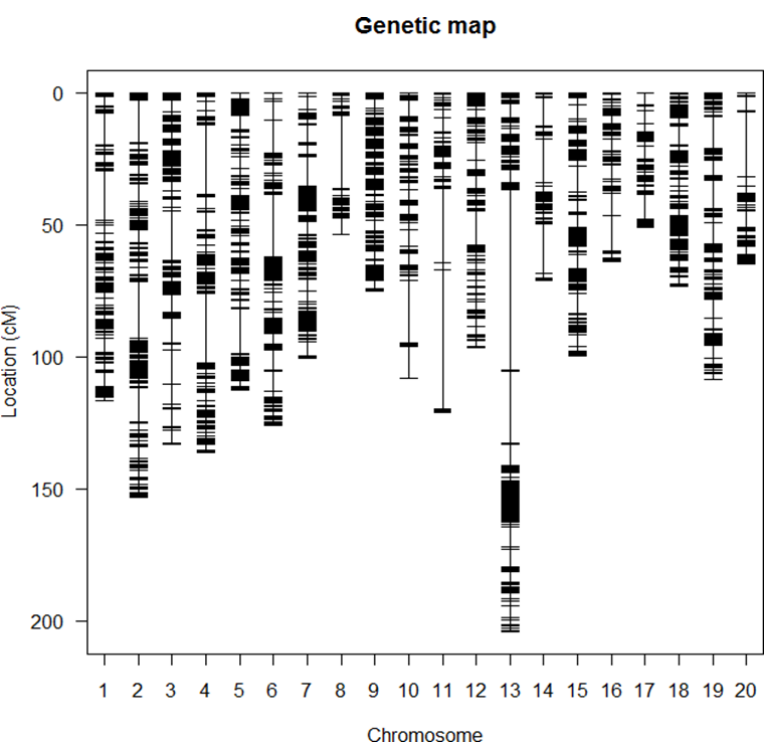
Figure 1. Molecular map of the Essex × Williams 82 F 5:11 population of 302 recombinant inbred lines mapped with 12,732 linked SNPs.